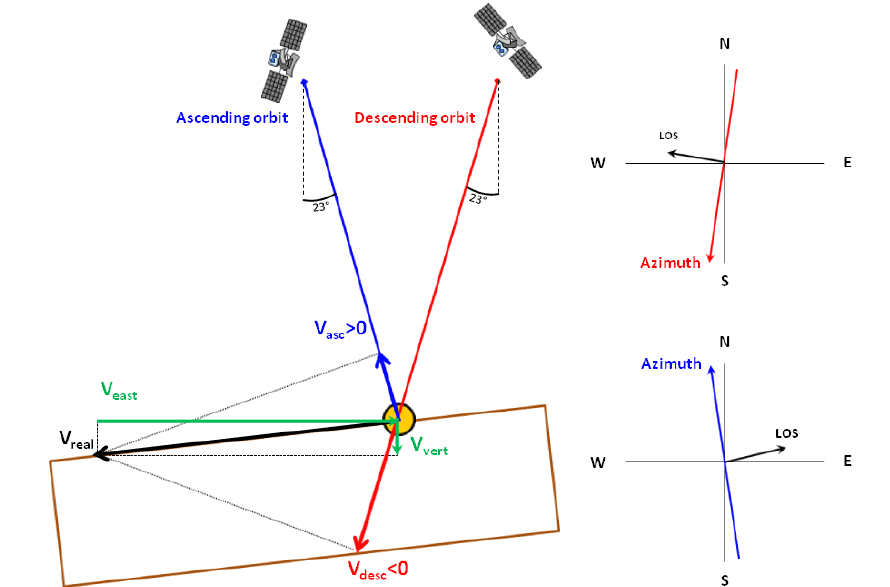
Figure 4. Extraction of vertical and horizontal (E-W) deformation components, projecting the ascending and descending acquisition